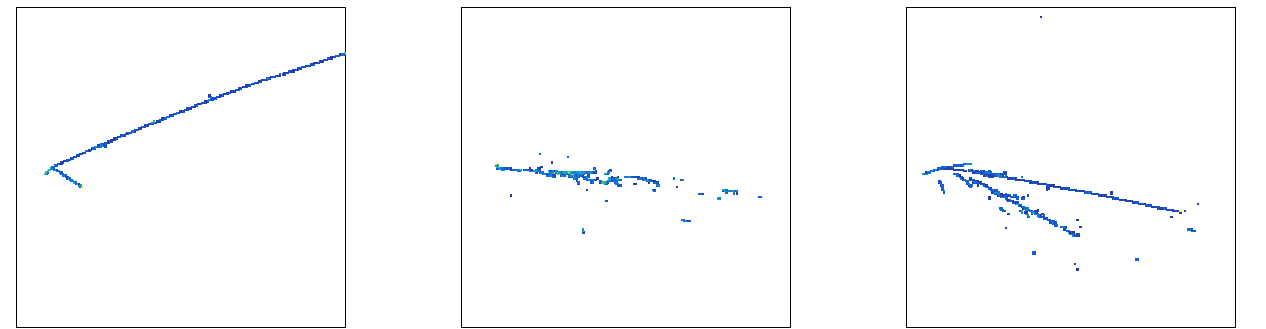
Fig. 1 Three simulated neutrino interactions shown in the (w, x ) view. Examples of a CC ν μ , a CC ν e and an NC interaction are shown in the left,centreandrightpanels,respectively.Eachimageis224 × 224pixels,